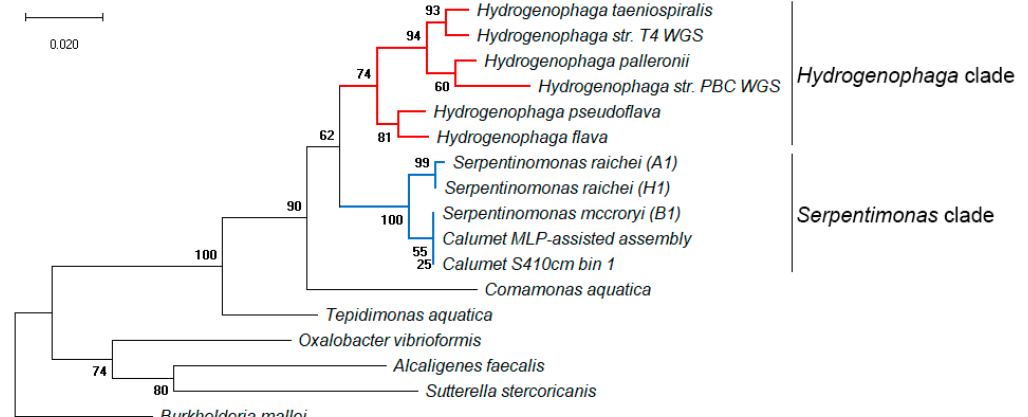
Figure 8. Maximum Likelihood phylogenetic tree of 16S rRNA genes from select members of order Burkholderiales. Highlighted in red: Hydrogenophaga species in the NCBI database, typically not associated with extreme alkalinity. Highlighted in blue: the Calumet draft genomes, clustered with three Serpentinomonas strains isolated from the Cedars serpentinizing springs in California, USA. Serpentinomonas raichei was previously identified as Comamonadaceae strains A1 / H1, and Serpentinomonas mccroryi as Comamonadaceae strain B1. Bootstrap support values from 1000 iterations are given in bold next to associated nodes.